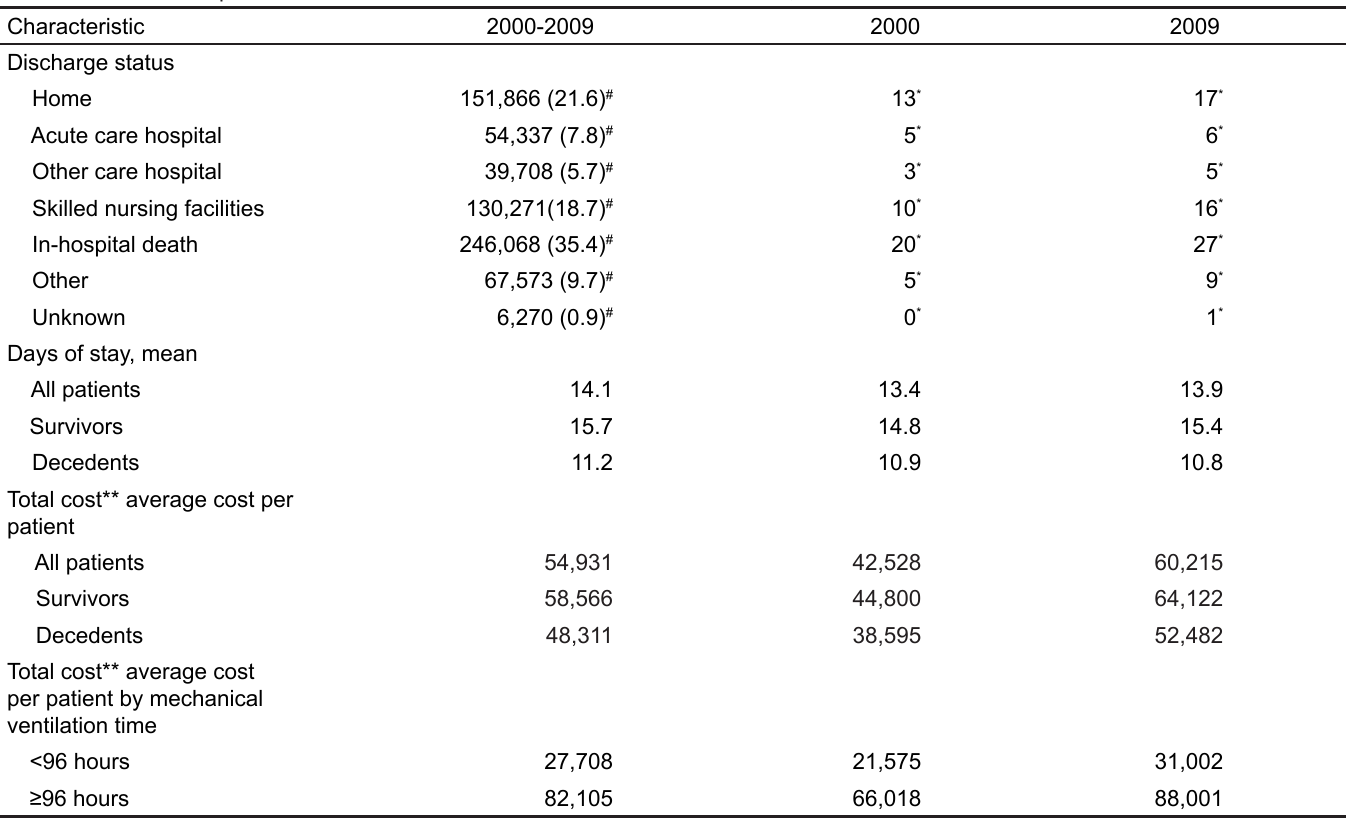
Table 2. Outcomes of patients who received mechanical ventilation in California,